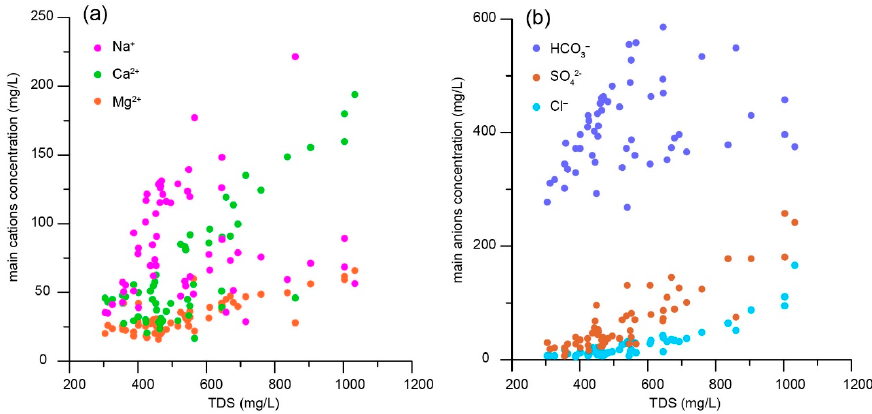
Figure 5. Scatter plots for ( a ) the main cations and ( b ) the main anions versus TDS.